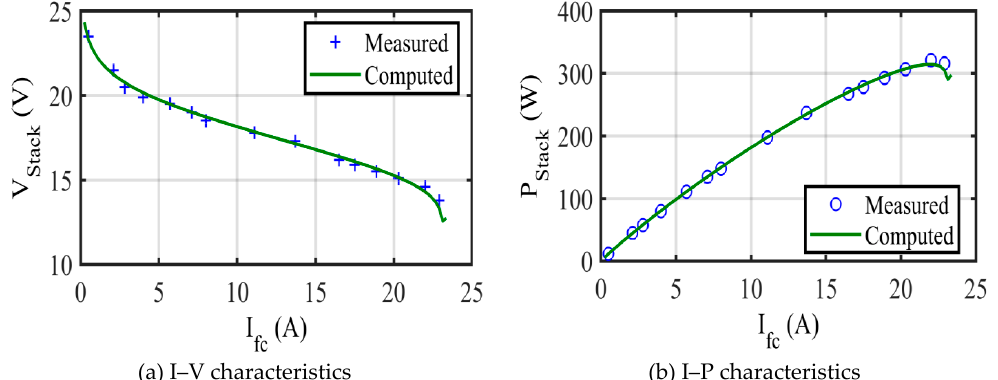
Figure 9. Characteristics of the 250 W stack.